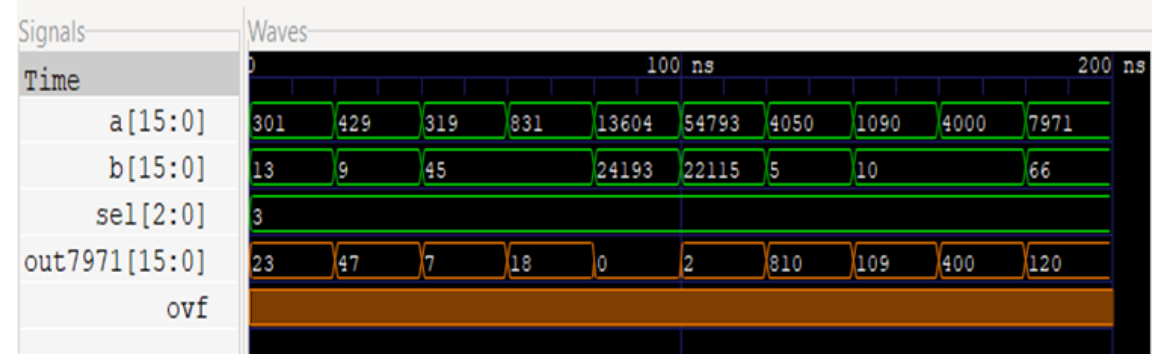
Figure 13. Waveform results from the 16 × 16 division